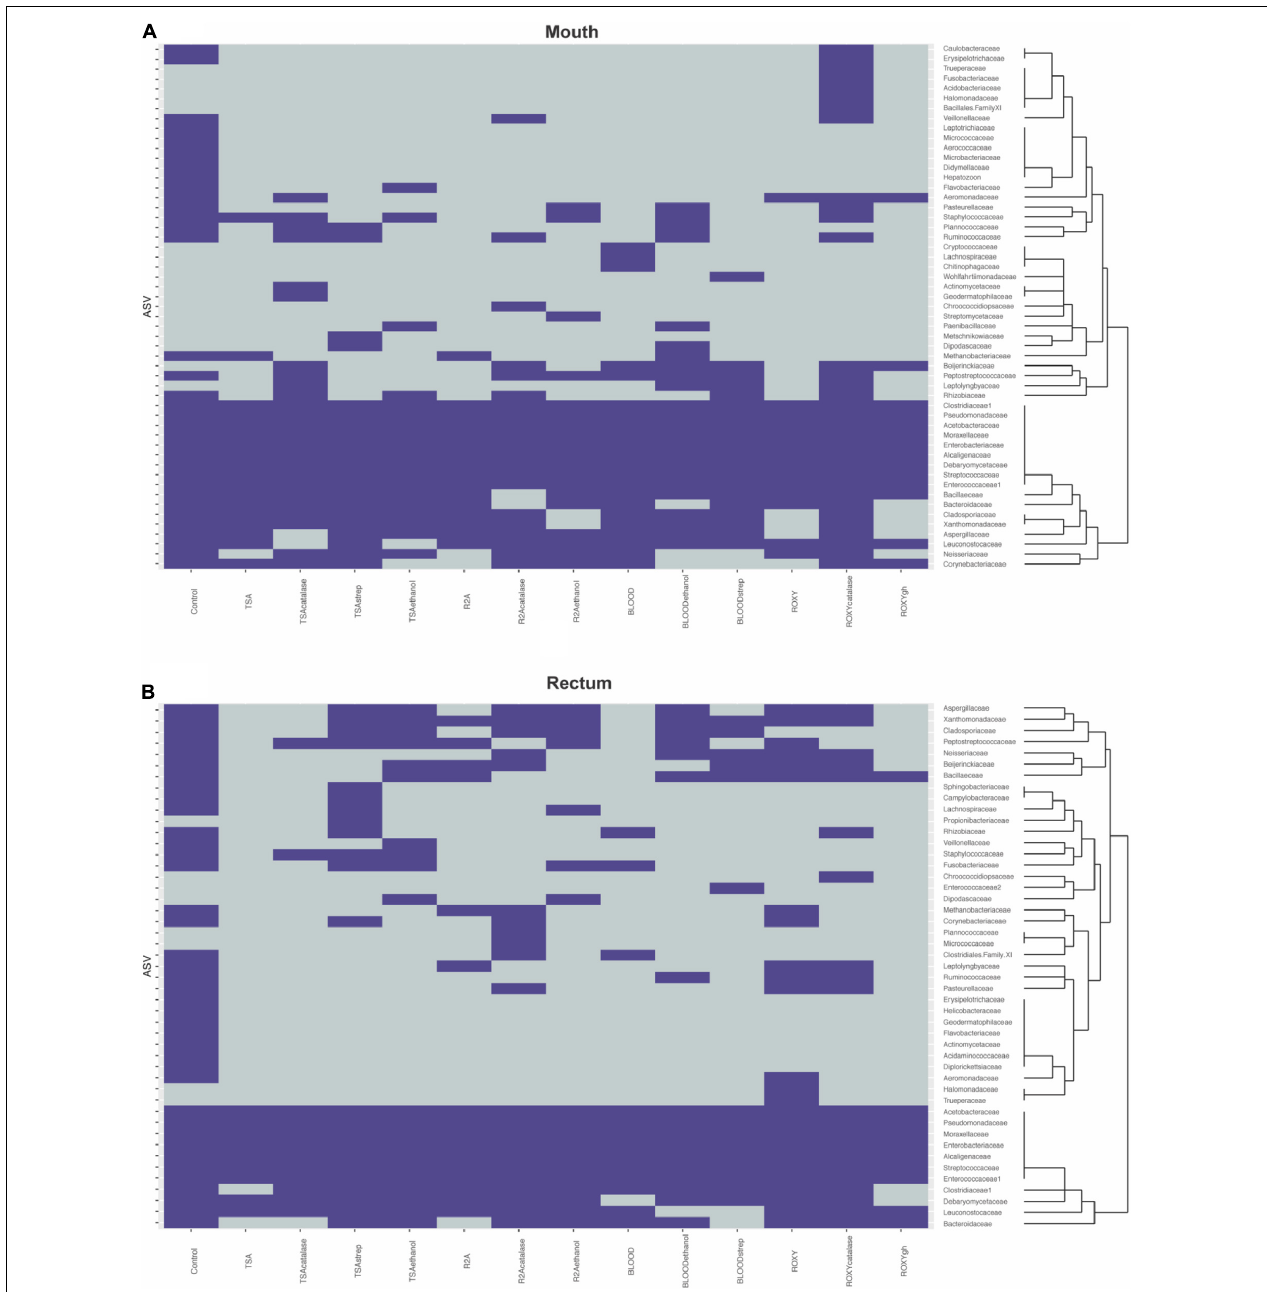
FIGURE 4 | Heatmaps describing presence absence of taxonomic families observed in the (A) mouth and (B) rectum. Purple indicates that a family was observed while gray indicates that a family was absent. The dendrograms highlight clusters of families observed during cultivation. Control refers to the families identified on the molecular